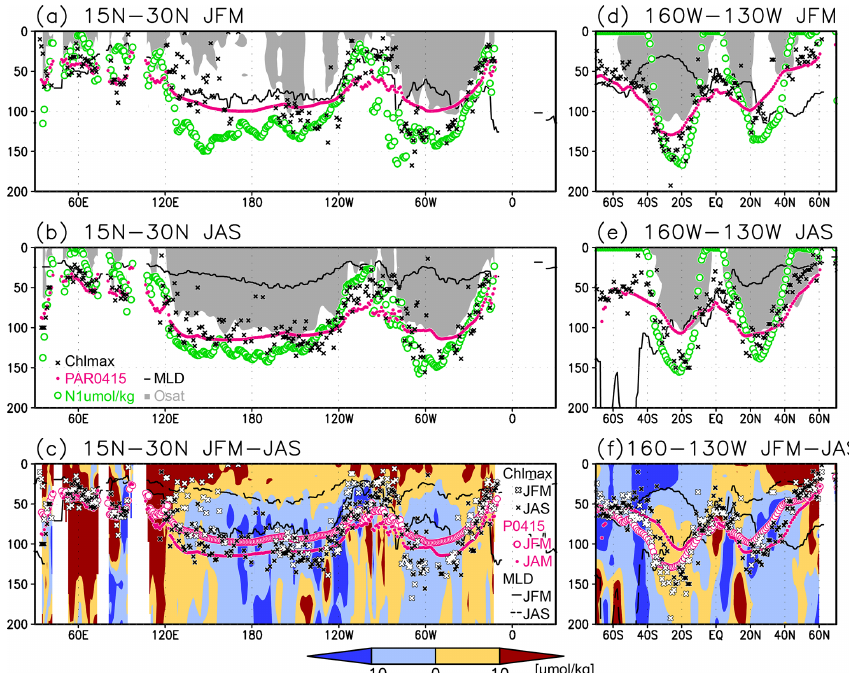
Figure 8. (a, b) Depths of the chlorophyll a (Chl a ) maximum (black crosses), photosynthetically active layer ( > 0 . 415molm − 2 d − 1 of photosynthetically available radiation, shown as magenta dots), nitrate-depleted layer ( < 1µmolkg − 1 of nitrate, shown as open green circles), mixed layer (black line), and oxygen-oversaturated layer (gray shading) at 15–30 ◦ N (northern subtropics) in (a) January–March (JFM) and (b) July–September (JAS). (c) Difference between dissolved oxygen concentrations during JFM and JAS (color scale) and depths of the Chl a maximum, photosynthetically active layer, and mixed layer in JFM and JAS (white and black crosses, open and solid magenta dots, and solid and dashed black lines, respectively) at 15–30 ◦ N. Panels (d–f) are the same as (a–c) but are at 160–130 ◦ W (Pacific